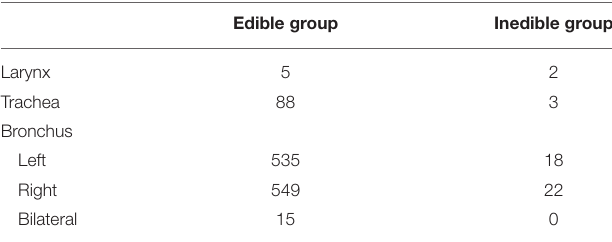
TABLE 2 | Clinical features of the edible foreign body group and the inedible group.